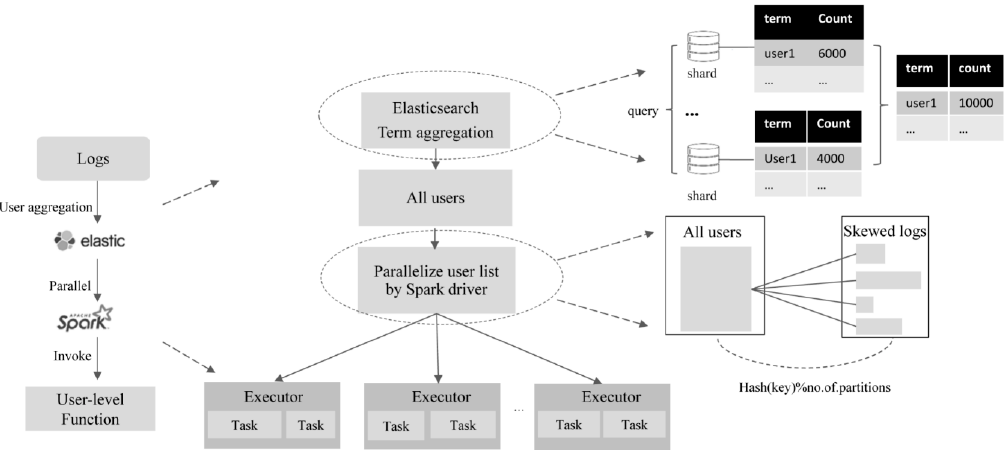
Figure 6. The skewed data problem caused by the default HashPartitioner.